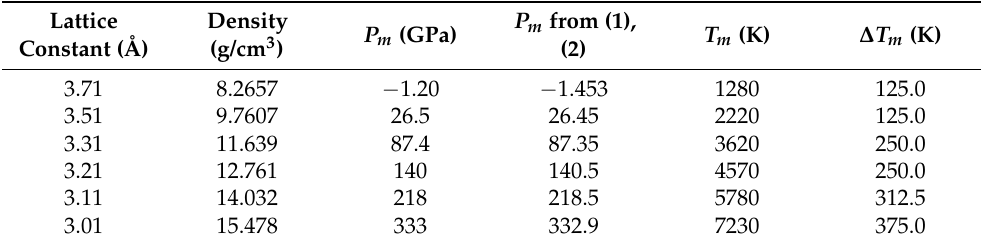
Table 1. The six ab initio melting points of fcc-Cu, ( P m , T m ± ∆ T m ) , obtained from the Z method implemented with VASP.